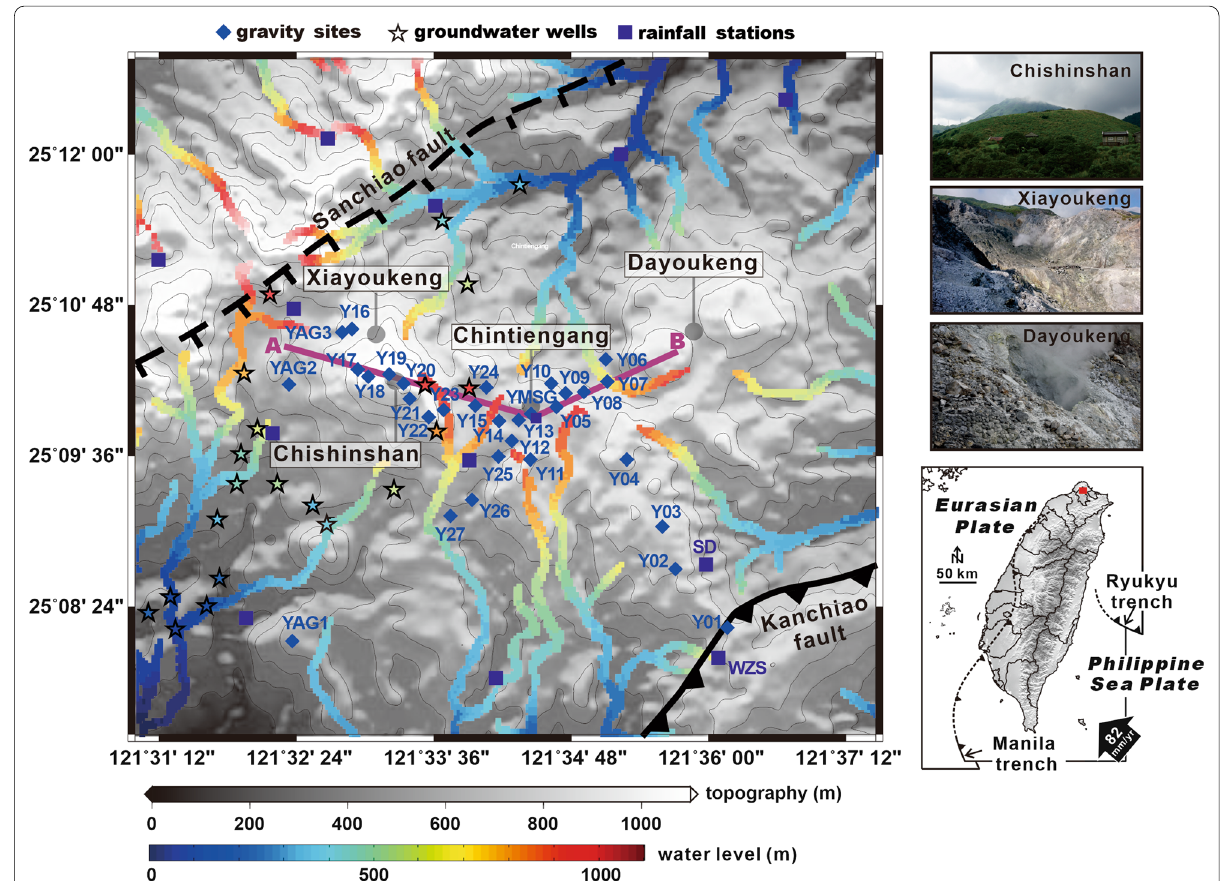
Fig. 1 (left panel) Locations of gravity monitoring sites, groundwater wells, and rainfall stations in the TVG used in this study. Note that YMSG is a hybrid site for SG, AG, and RG gravity observations, located in Chintiengang. The water levels are for April 2012. The bold line from A to B indicates the location of the profile shown in Fig. 11. The right panel shows the summit (Chishinshan) and two fumaroles of the TVG and the geodynamic plate model and the location of the TVG in Taiwan (red square) (right lower